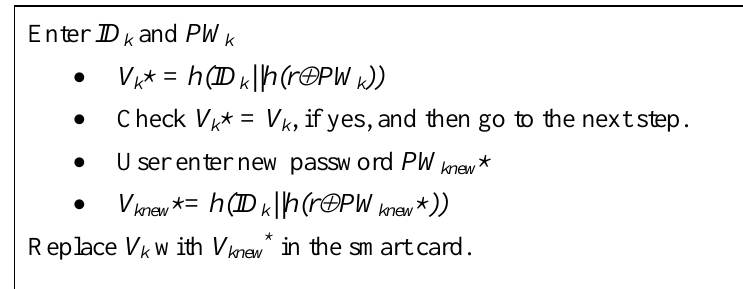
Figure 4. Flow of password update